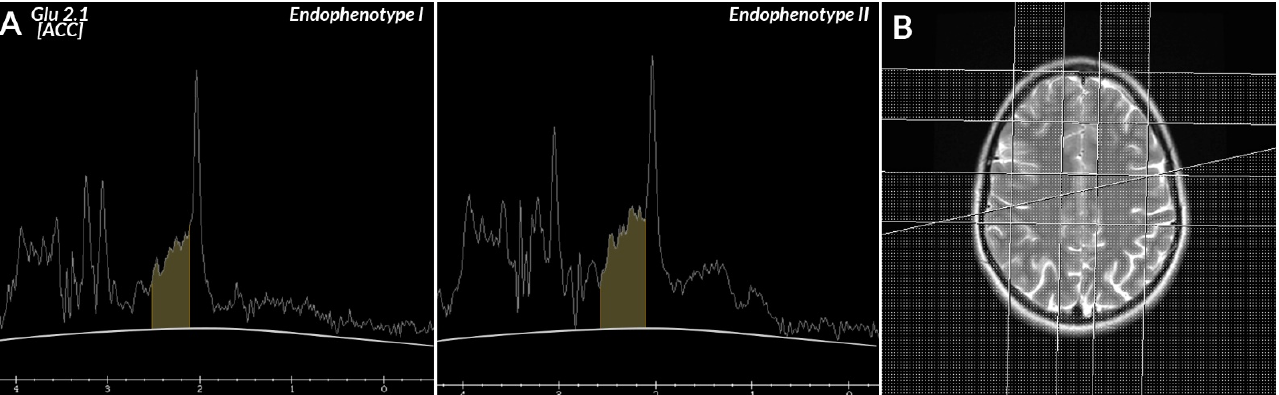
Figure 5. ( A ). On the MR spectrum, the yellow line is at the level of glutamatergic neurotransmission metabolites Glu, Gln (2.1–2.5 ppm) peak in endophenotype I, and the yellow line is at the level of Glu, Gln (2.1–2.5 ppm) peak in endophenotype II. ( B ). T2 weighted axial image, with the location of VOI in the ACC region.